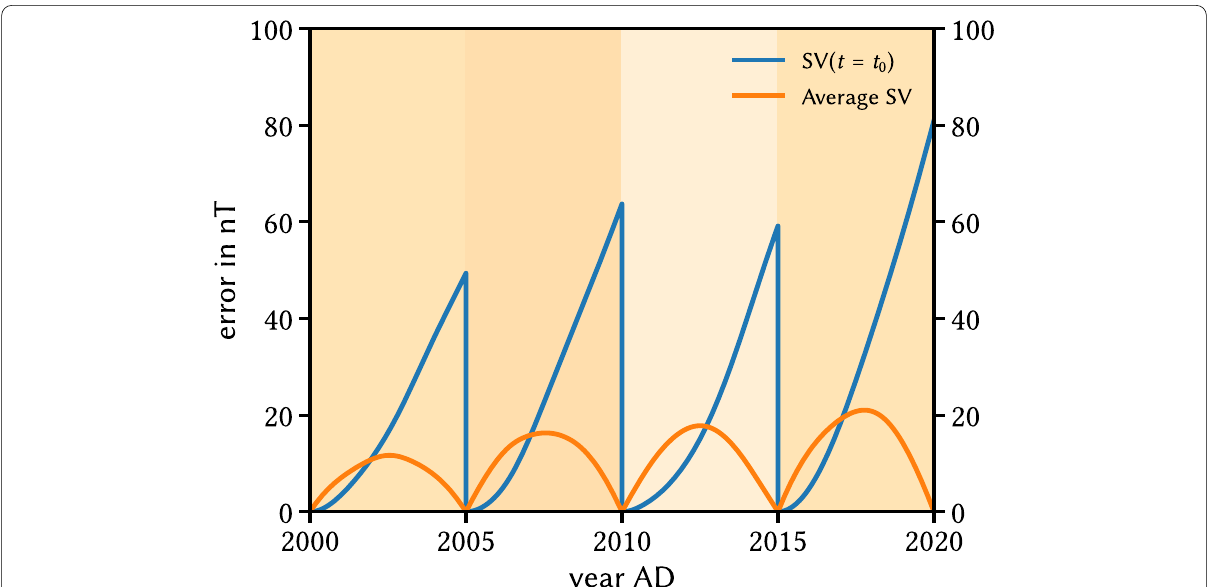
t / 5 (integer = t 0 (blue curve) or to the =